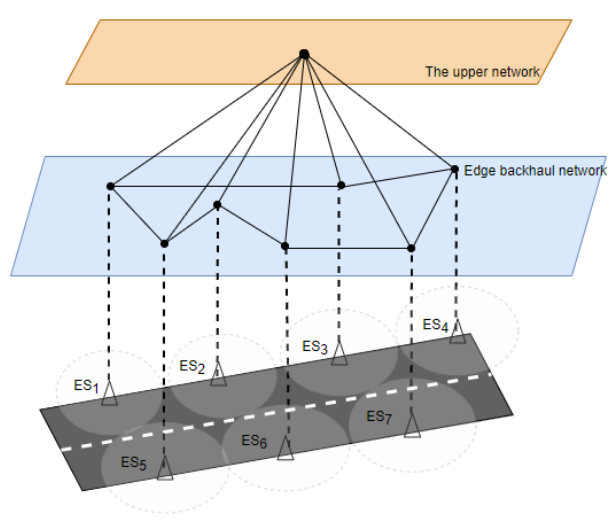
Figure 1. Network model.